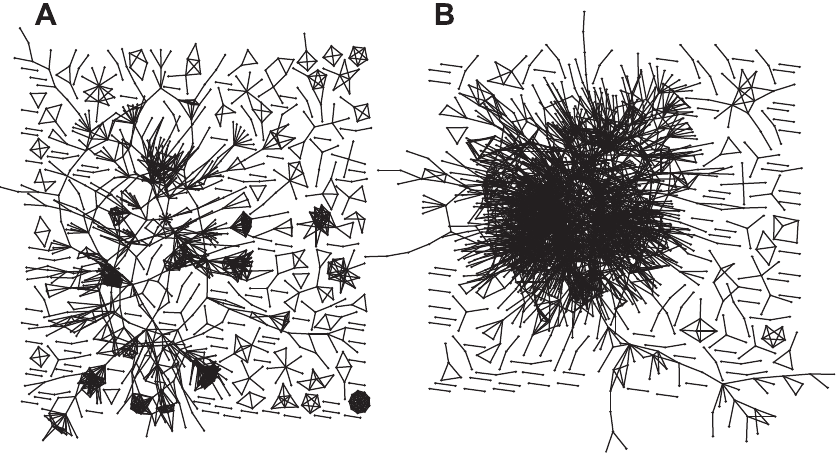
Figure 1. Comparison of Network Topology (A) Layout of FYI network [17]. (B) Layout of HC fyi network. The small size and fragmented nature of FYI as compared to HC fyi are evident: FYI contained 160 disconnected components with 57% in the main component, whereas HC fyi contained 37 disconnected components with 93% in the main component. The global organization of FYI network is that of dense local regions that are sparsely interconnected (altocumulus structure), whereas that of the HC fyi is densely interconnected overall, suggestive of extensive coordination and dependencies among diverse processes (stratus structure). DOI: